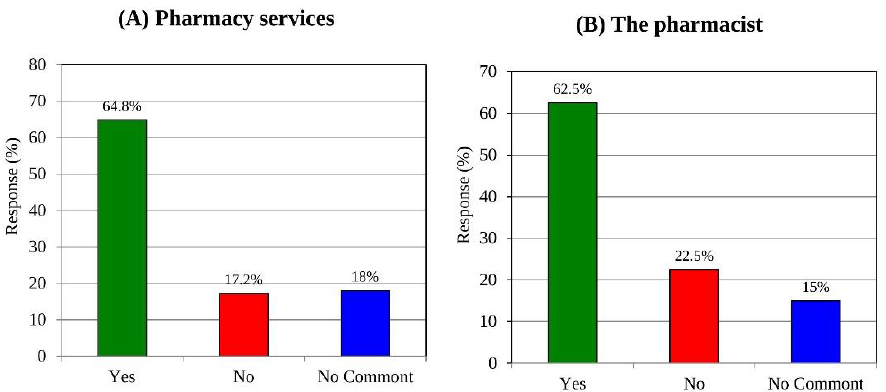
Figure 6. Categorical distribution of respondents’ level of satisfaction with the pharmacy services ( A ) and their community pharmacist ( B ).